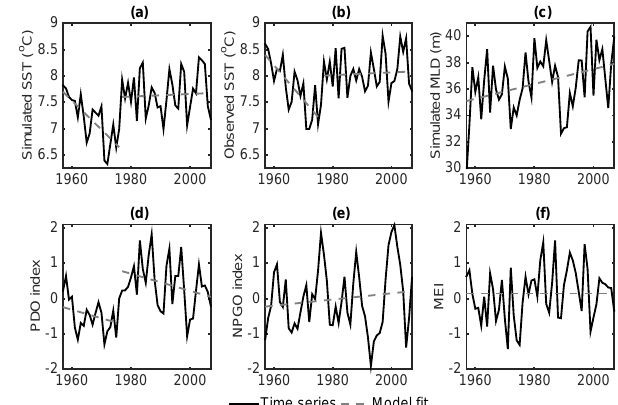
Figure 3. Time series of (a) simulated sea surface temperature (SST), (b) observed SST and (c) simulated mixed-layer depth (MLD) for the Gulf of Alaska. The simulated time series of SST and MLD are the same in the five ocean models used. Time series of large-scale oscillations representing the climate in the Gulf of Alaska: (d) Pacific Decadal Oscillation (PDO) index, (e) North Pa- cific Gyre Oscillation (NPGO) index and (f) multivariate El Niño Southern Oscillation index (MEI). The grey dotted lines represent the statistical model chosen (see Table A1) to fit these time series. Both the simulated SST and observed SST exhibit a significant shift in intercept and trend occurring in 1976 ( p value<0.05, see Ta- ble A1). The MLD time series do not exhibit a significant shift and is best represented by a linear trend. Among the large-scale oscilla- tions, only the PDO exhibits a significant shift in 1976.